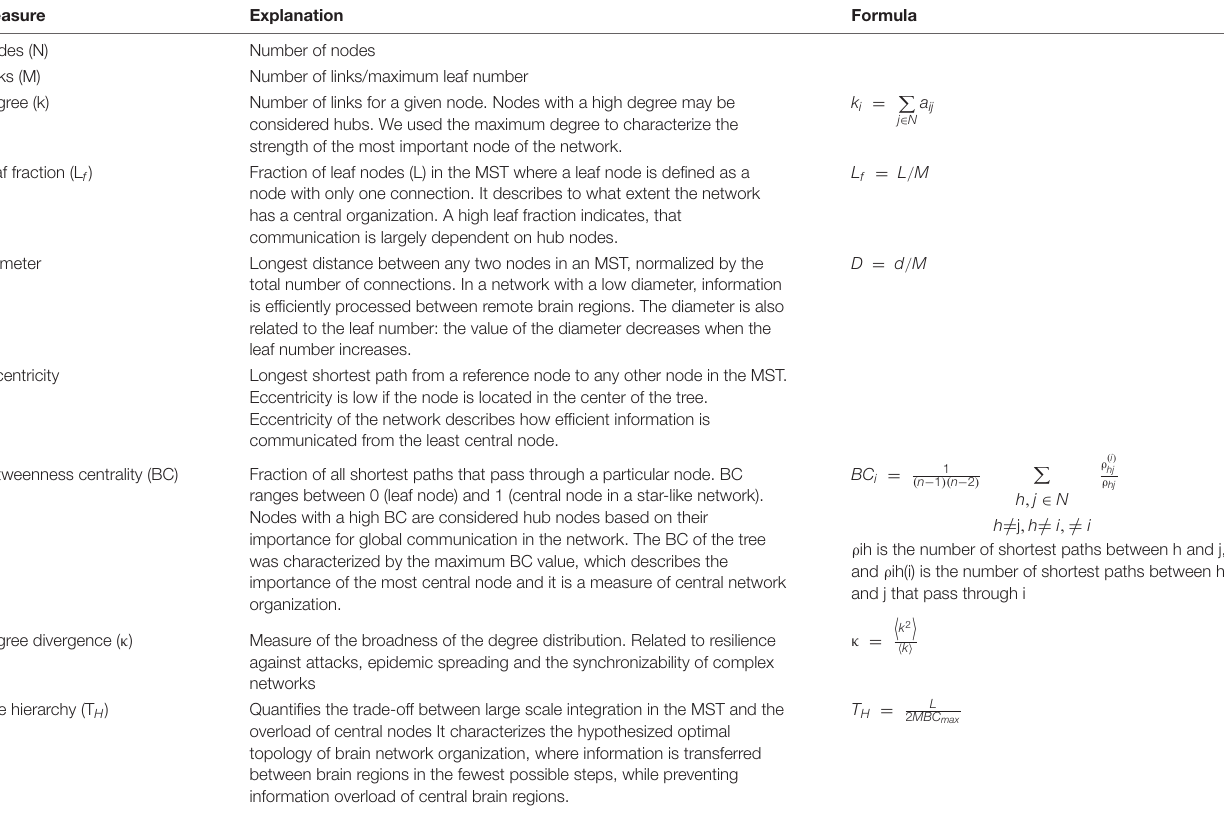
TABLE 2 | Explanation of concepts and terminology based on Tewarie et al. (2015) and Van Dellen et al.